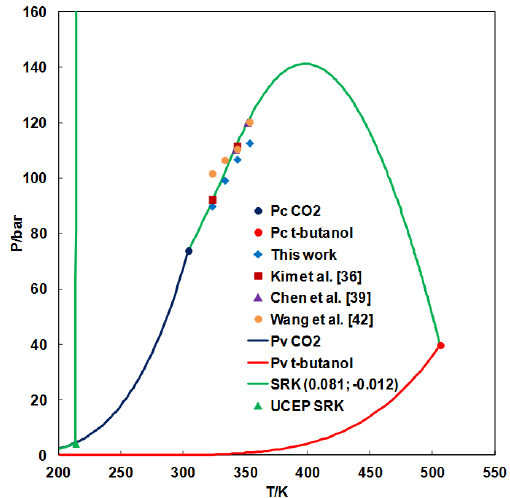
Figure 6. P−T fluid phase diagram of carbon dioxide + 2-methyl- 2-propanol binary system: blue full diamond ( ♦ ), this work orange full circle ( ● ), [42 ], purple full triangle ( ▲ ), [39], dark red full square ( ■ ), [36] - experimental critical curve; dark blue full circle ( ● ) and red full circle ( ● ), experimental critical points of pure components; dark blue and red solid lines (—,—), calculated vapor pressure curves of pure components; green full triangle ( ▲ ), calculated UCEP and green solid lines ( ▬ ), calculated critical curves and LLV lines respectively by SRK/ ( k = 0.081, l = 12 12